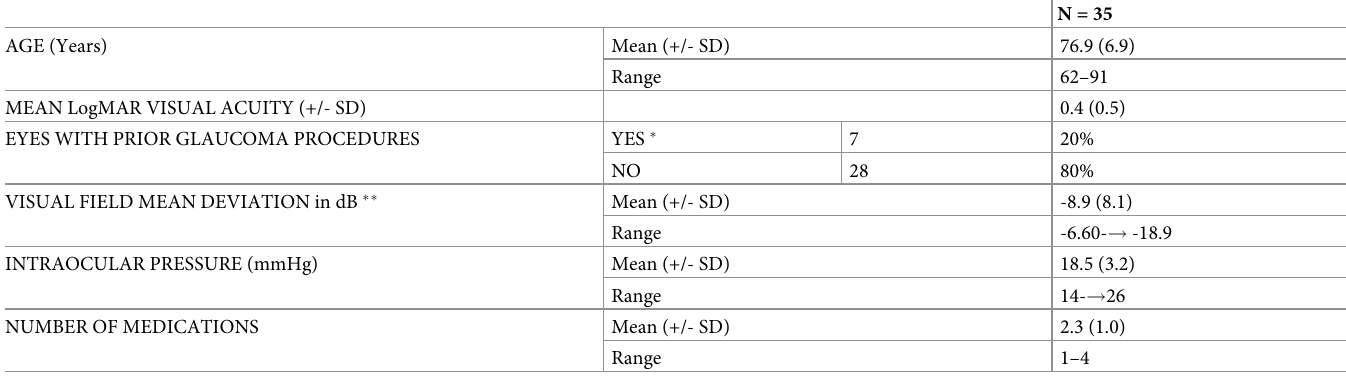
Table 1. Demographic and pre-operative